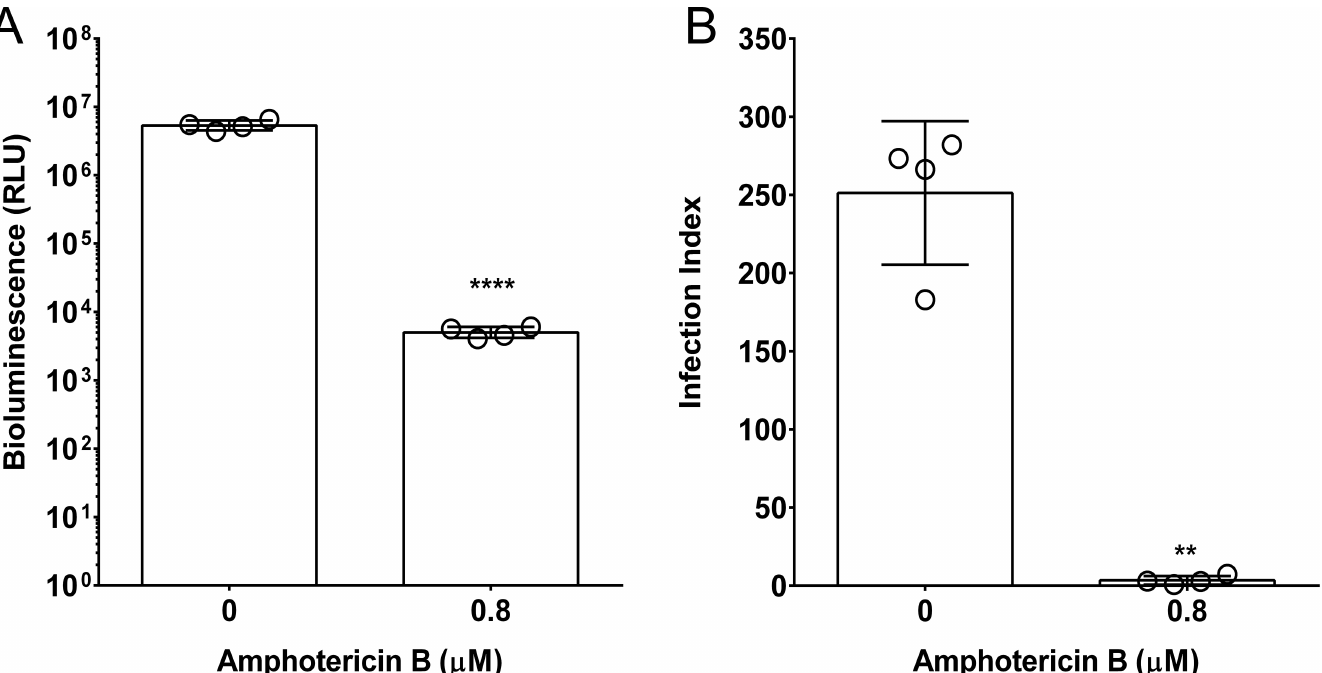
Fig 2. Comparison of bioluminescence- and microscopy-based intramacrophage infection assays following treatment with a supralethal dose of Amphotericin B. (A) The bioluminescence-based assay was used to assess infection of PMA-differentiated THP-1 macrophages by stationary phase L . mexicana NanoLuc-PEST promastigotes. Infected cells were exposed to 0.8 μ M Amphotericin B, or left untreated, for 72 hours. Mean values are shown (n = 4) ± SD. The Y-axis was transformed by log 10 , and the data was analysed by paired, two-tailed T-test ( p < 0.001). (B) The standard microscopy-based counting assay was used to assess infection of PMA- differentiated THP-1 macrophages by stationary phase L . mexicana NanoLuc-PEST promastigotes Infected cells were exposed to 0.8 μ M Amphotericin B, or left untreated, for 72 hours. Infection indices were calculated as described in the methods. Mean values are shown (n = 4) ± SD. The data was analysed by paired, two-tailed T-test on the infection index data ( p = 0.0017).